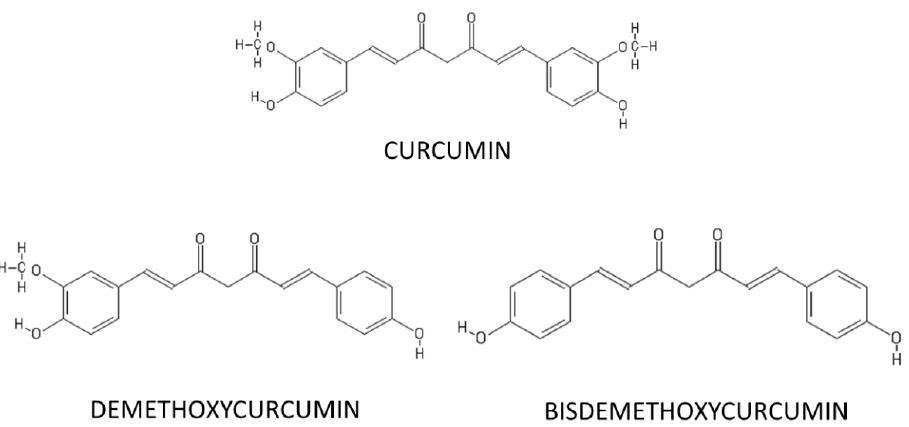
Figure 1. Chemical structure of curcumin and other curcuminoids such as Demethoxycurcumin and Bisdemethoxycurcumin, obtained from the rhizomes of Curcuma Longa .